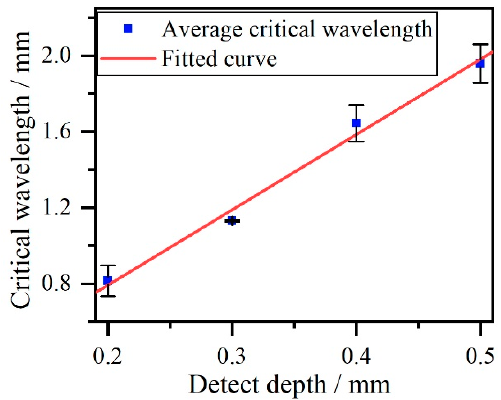
Figure 16. The fitted curve of critical wavelength vs crack depth.